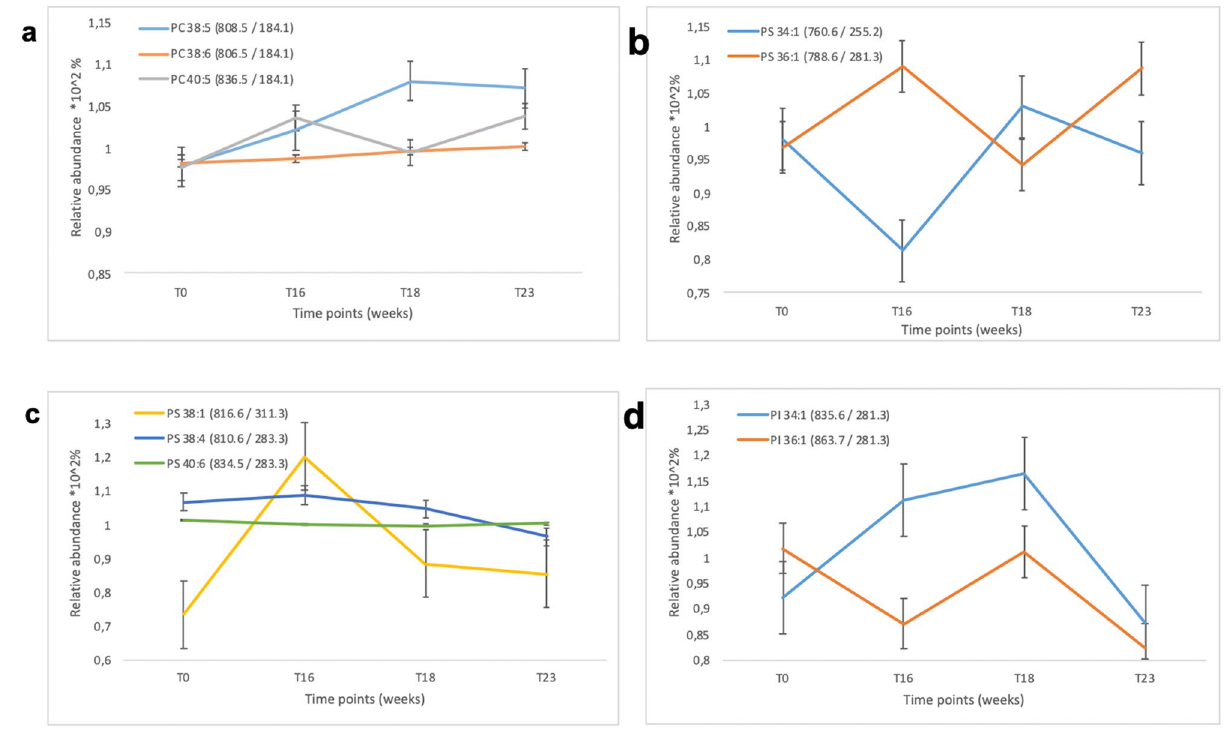
Figure 4. Relative variation of log ratios of peaks intensities obese on control over time: (a) Phosphatidyl choline variation (PC 38:5; PC 38:6 and PC 40:5). (b,c) Phosphatidyl serin variation (PS 34:1; PS 36:1; PS 38:1; PS 38:4 and PS 40:6). (d) Phosphatidyl Inositol variations (PI 34:1; PI